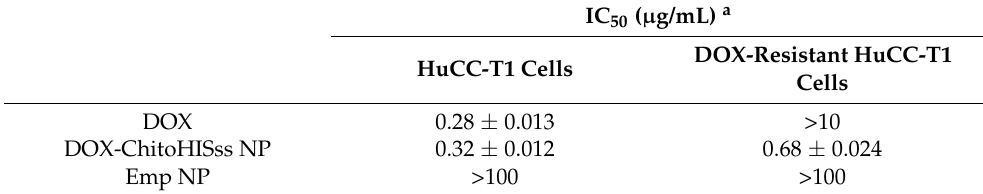
Table 2. IC 50 value of DOX or DOX-incorporated ChitoHISss nanoparticles.